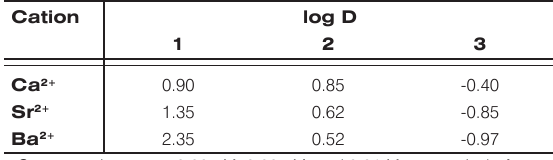
Figure 6. The extraction of lanthanides(III) from 0.1 M HNO solutions with 0.01 M solutions of compounds 1 and 3 in 1,2-dichloroethane in the presence 0.05 M HPic.